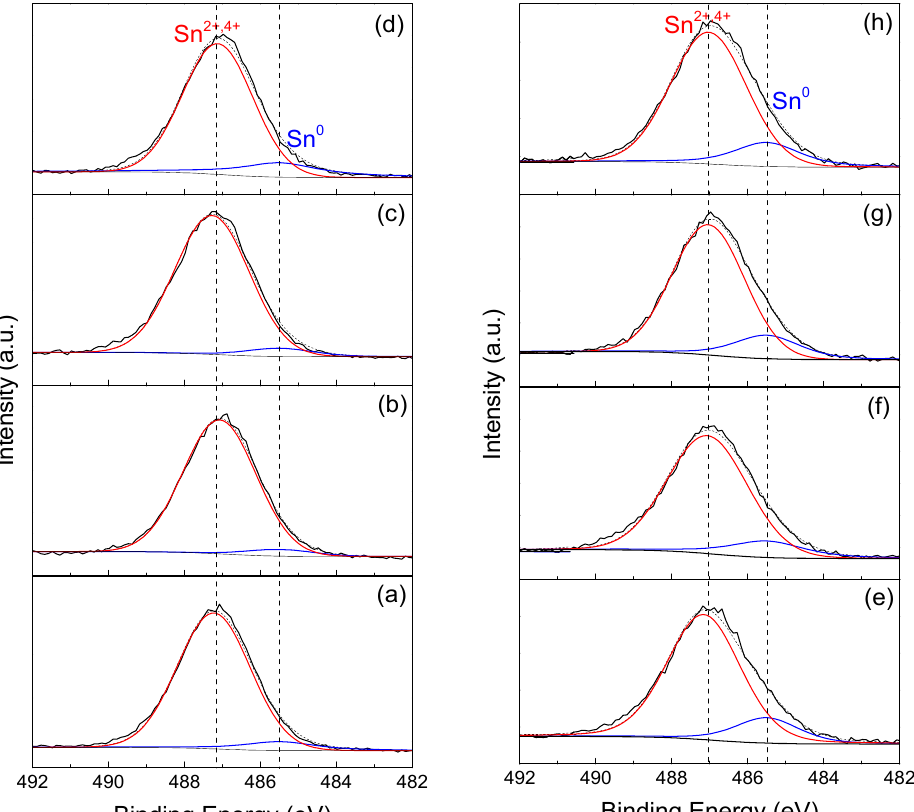
Figure 8. XPS Sn 3d curves of catalysts. ( a ) PtSn-C, ( b ) PtSn-B, ( c ) PtSn-B-HCl5, ( d ) PtSn-B-HCl35, ( e ) reduced PtSn-C, ( f ) reduced PtSn-B, ( g ) reduced PtSn-B-HCl5, and ( h ) reduced PtSn-B-HCl35.